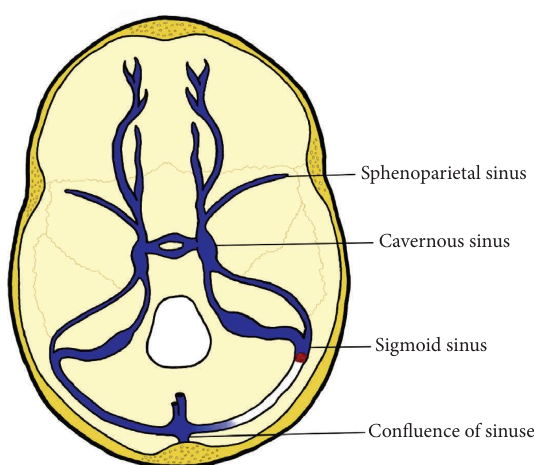
Figure 2: Anatomy of the cerebral venous system and sigmoid sinus